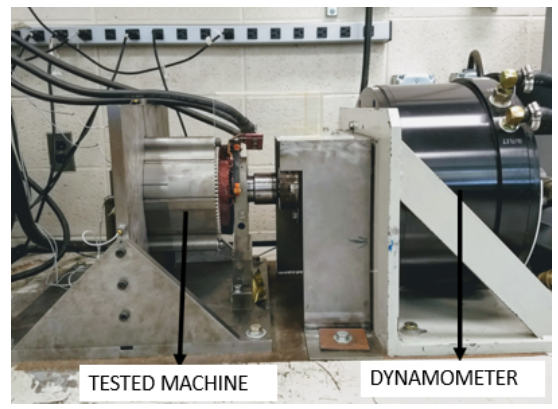
Figure 9. Experimental set up [24].